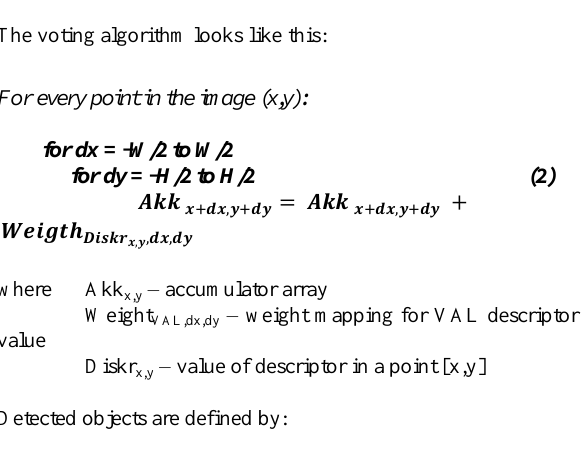
Figure 5. An example of weights array for some descriptor value. Descriptor with some fixed value (on the left). Weight map with possible center positions (on the right).